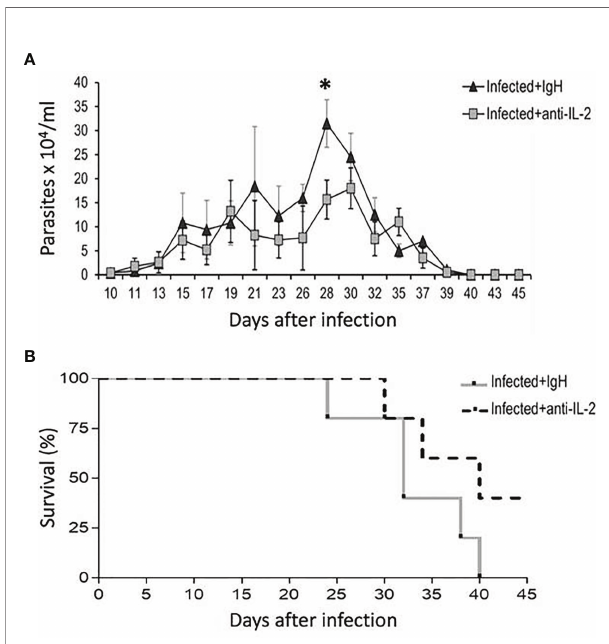
FIGURE 2 | Parasitemia and survival rates of mice treated with blocking antibody to IL-2 or rat Ig in C57Bl/6 infected mice. The number of parasites in the bloodstream of C57Bl/6 mice treated with blocking mAb to IL-2 or rat Ig is shown in panel (A) . Statistical signi fi cance was observed only at a one-time point, at the parasitemia peak (28 days after initial infection). Mann-Whitney test was used to compare different groups of mice (*P < 0.05). Panel (B) shows that survival rates were higher in the group treated with anti-IL-2 mAb compared to infected controls treated with rat Ig (P < 0.05, n = 10 at the beginning of the experiment, Gehan-Breslow-Wilcoxon